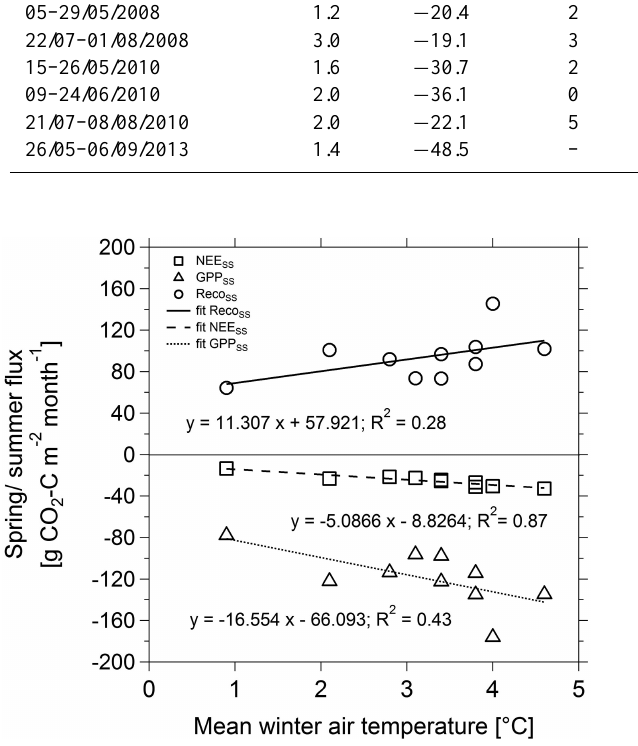
Figure 7. Daily ecosystem respiration as a function of water table depth during five dry spells (two in summer 2008 and three in